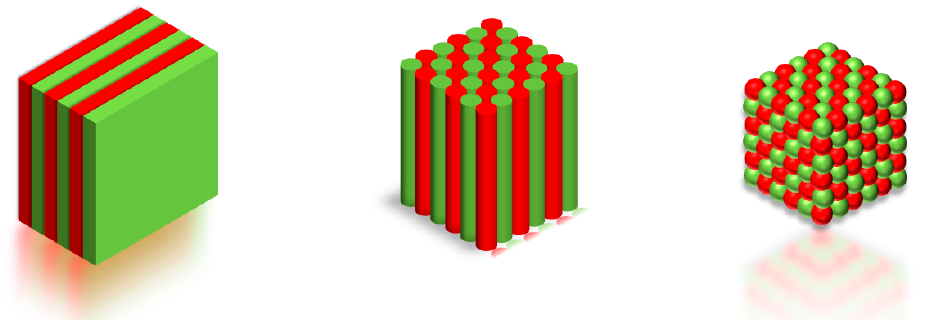
Figure 1. Sketch of the representation of the three kinds of photonic crystals. The different color represents materials with different dielectric constants. Adapted with permission from [1].